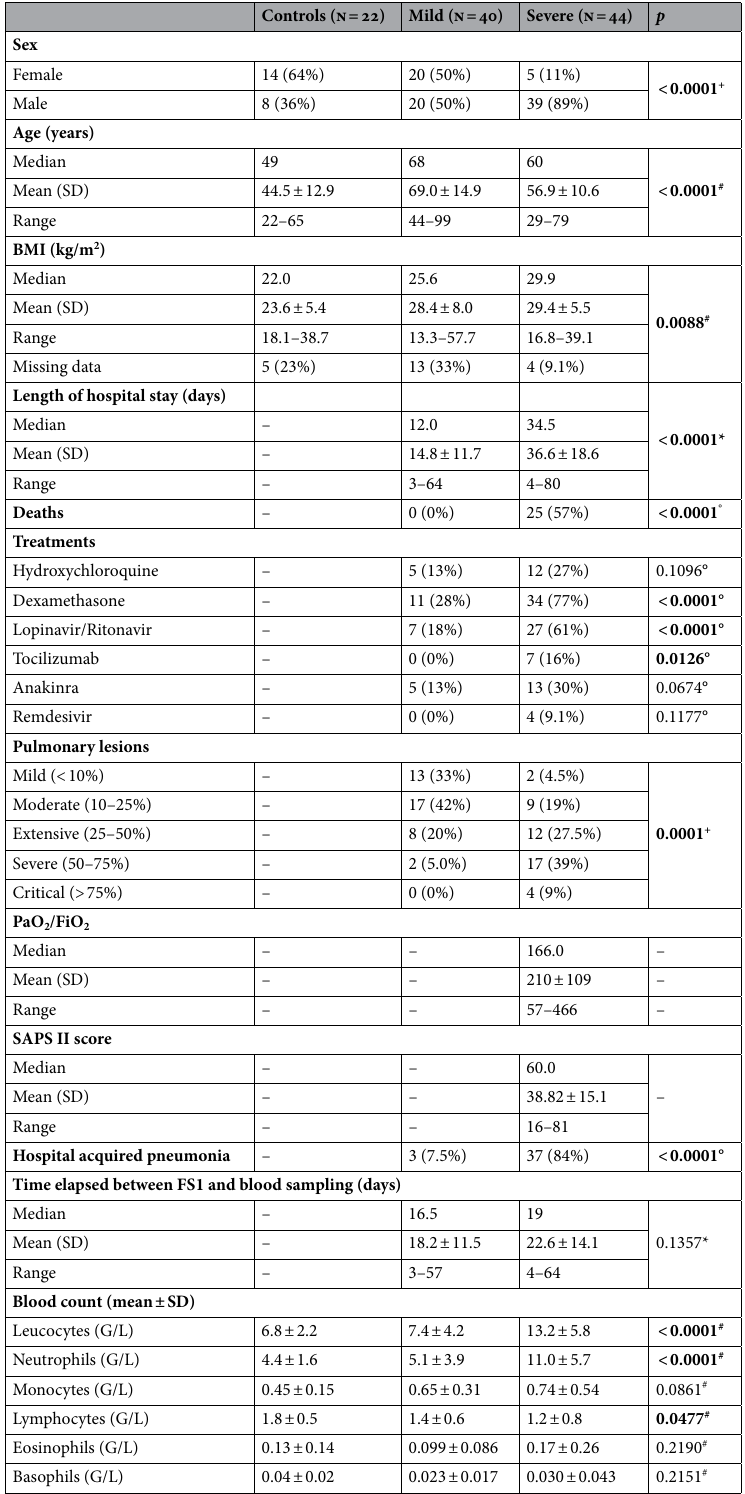
Table 1. Description of the cohort. *Student t-test ; + Chi-square test; °Fisher’s exact test; # ANOVA. FS1 : first day of functional